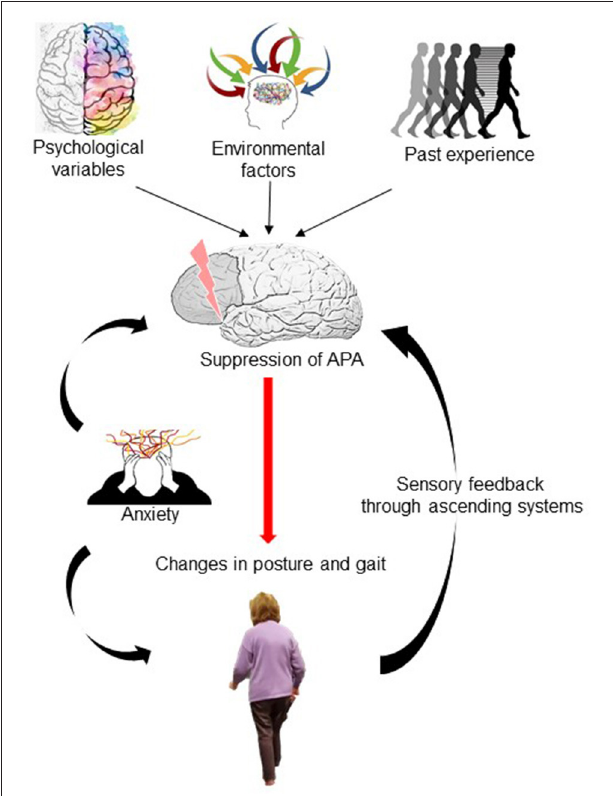
FIGURE 2 | Diagrammatic schema for gait impairment in Fear of Falling. Past experiences (previous falls or near-falls) combine with psychological variables (state anxiety, bodily hypervigilance) and environmental factors (uneven or sloping surfaces) to alter prefrontal cortex activation leading to a suppression of anticipatory postural adjustment (APA) activity. This occurs in an attempt to increase balance performance and safety by reducing the size, speed and amplitude of such postural adjustments. This however becomes a less successful movement strategy, increasing risk of falls through stiffening of posture, and leads to heightened perception of falls risk through ascending sensory feedback, further cementing the suppression of APA. Postural anxiety increases postural stiffening and contributes to APA